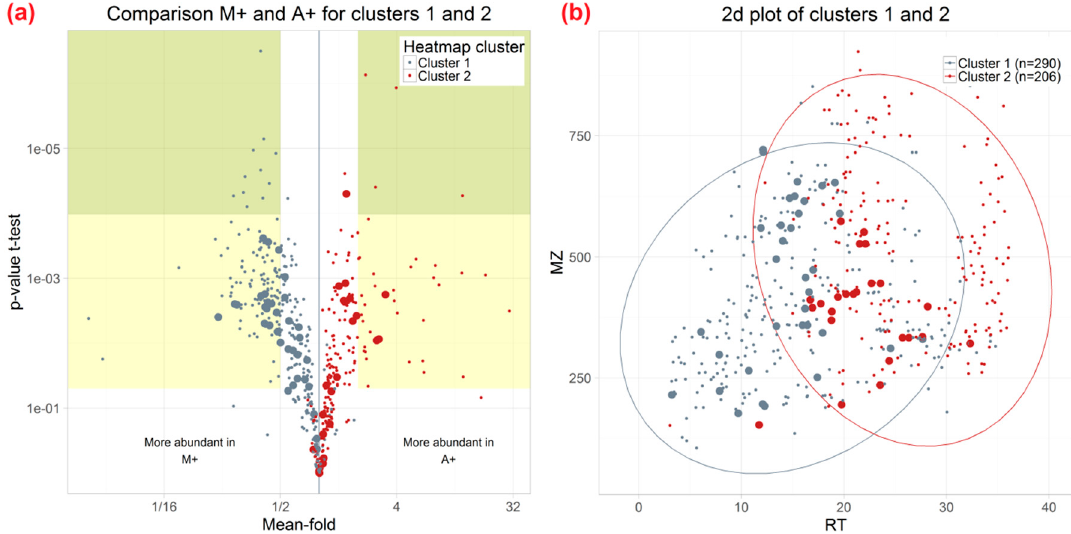
Figure 5. ( a ) Volcano plot of wheat ear metabolites consistently detected with all tested extraction mixtures (cluster 1 grey, cluster 2 red). p -values were calculated for the comparison of M+ and A+. Big dots represent annotated metabolites; ( b ) Retention time (RT) vs. m / z value plot for the same set of metabolites. Grey dots denote metabolites which were extracted with higher apparent efficiency by M+ while red dots refer to metabolites with higher abundance in A+-derived extracts.